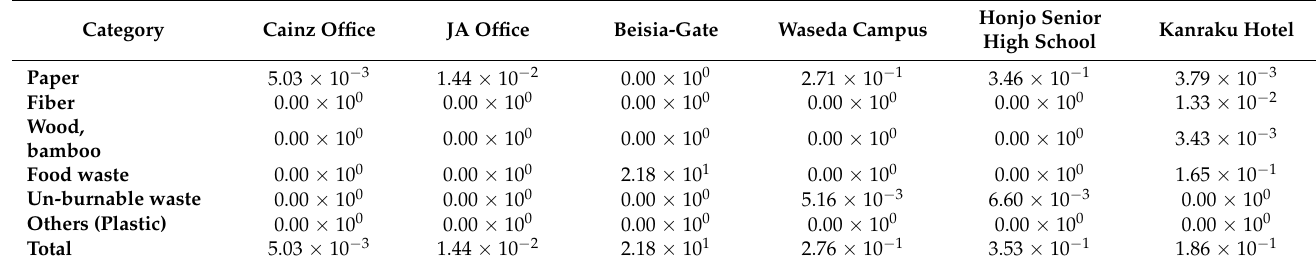
Figure 2. GHG Emissions of waste treatment sector in Honjo Waseda. Table 8. GHG emissions of each building (t-CO 2 e/day).